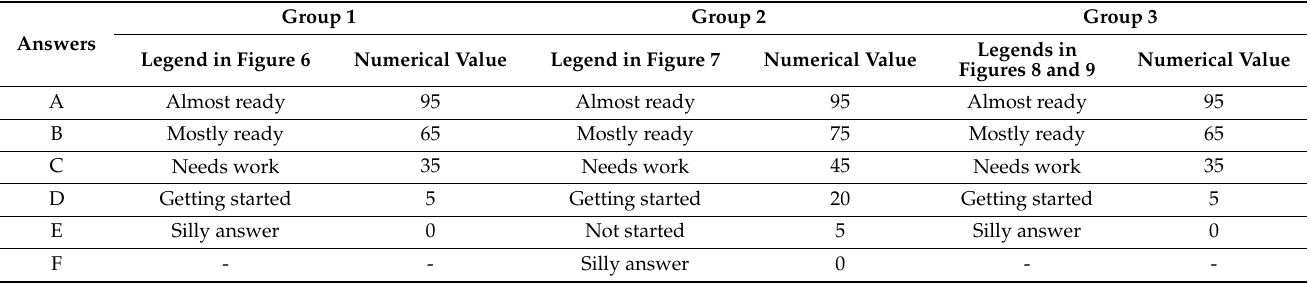
Table 5. Legends and assigned numerical values of each answer (source: author’s